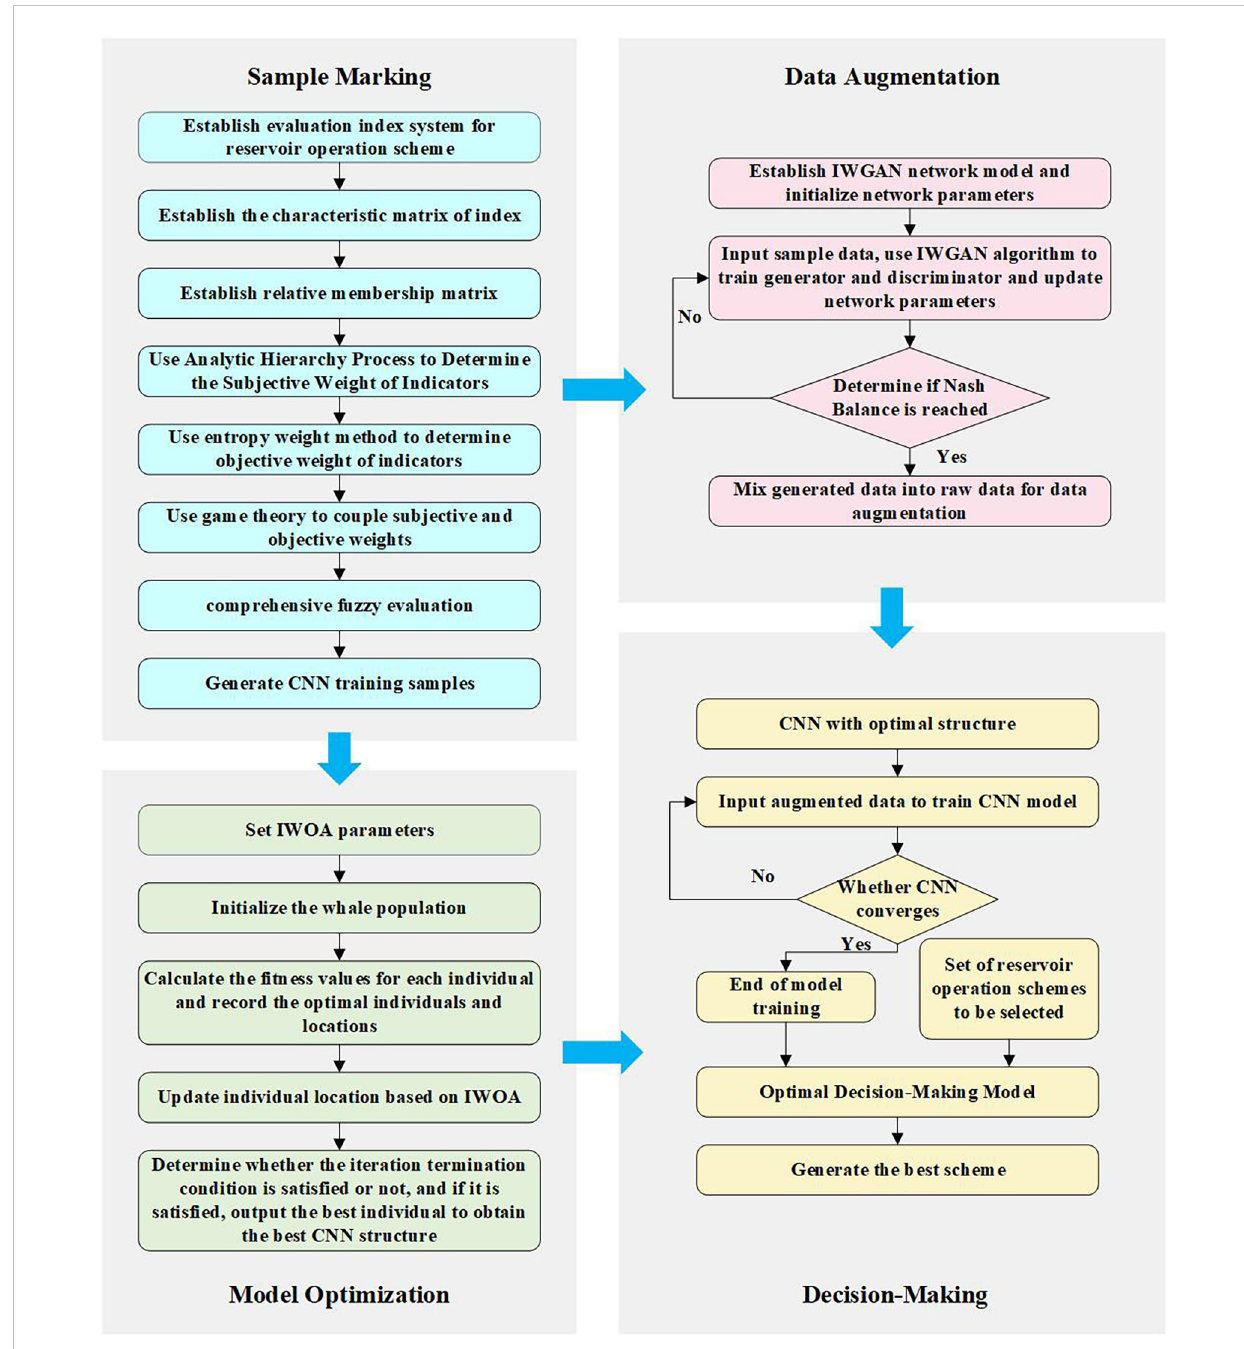
FIGURE 2 The framework of the decision-making method for reservoir operation